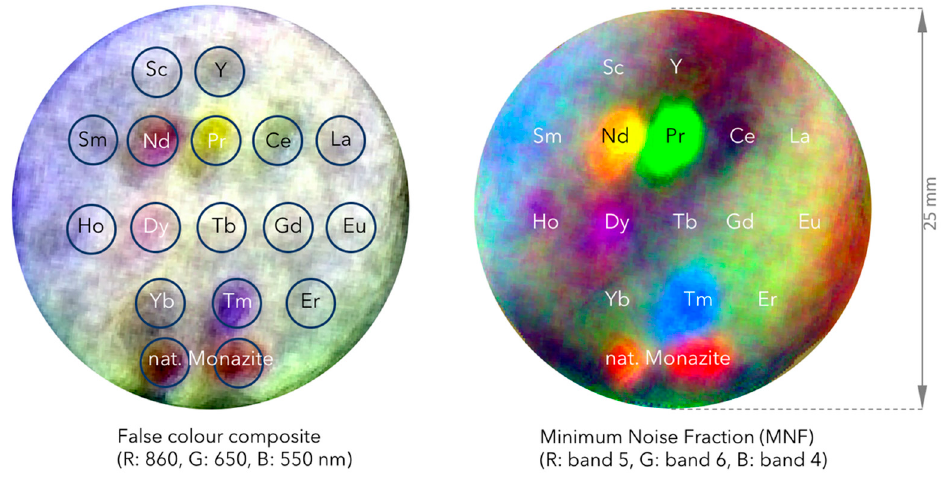
Figure 2. HS imaging of an REE-PO4 standard sample disc using a lightweight Senop Rikola sensor. The data are displayed as false colour and minimum noise fraction (MNF) [50] composite.